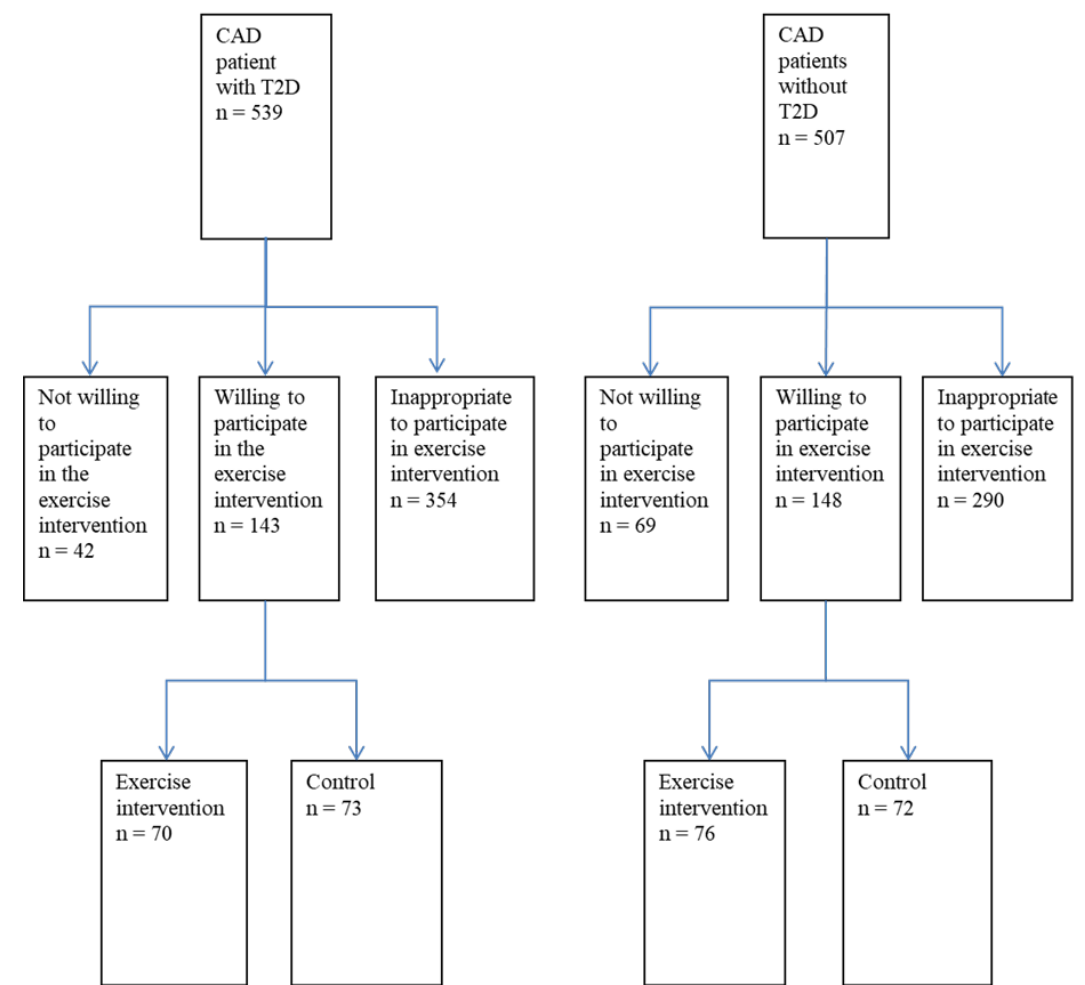
Figure 1. Patient selection protocol from the ARTEMIS database. Note: CAD, coronary artery disease; T2D, type-2 diabetes.